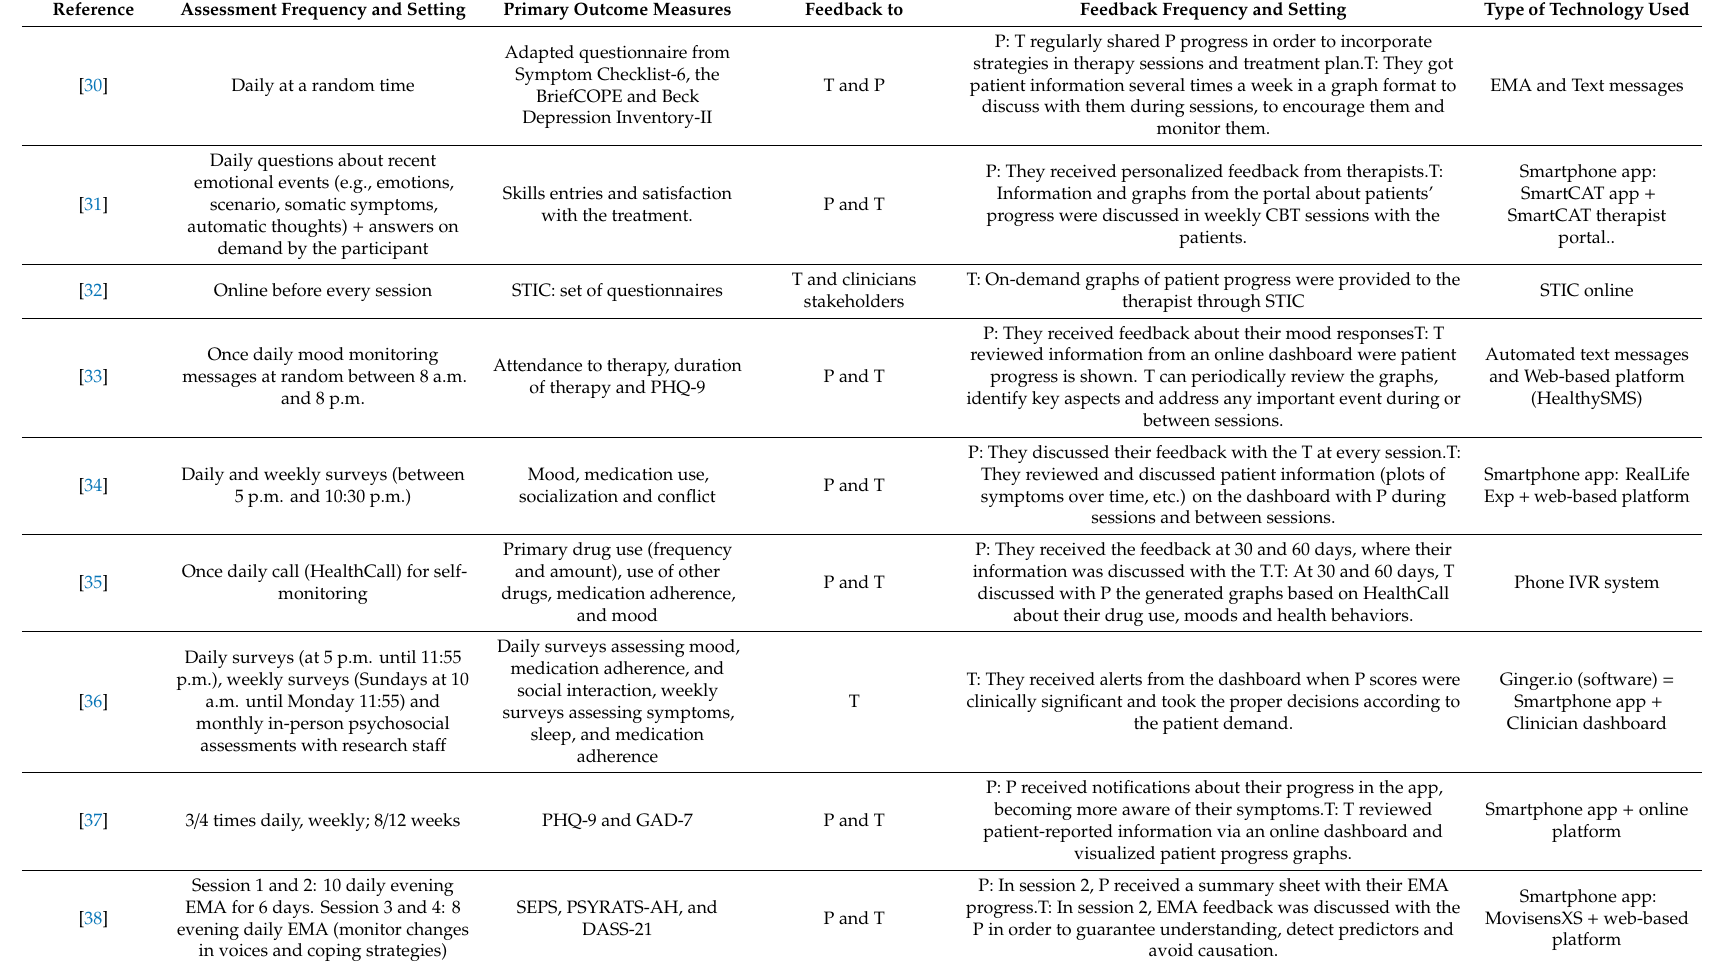
Table 2. Measurement-based care